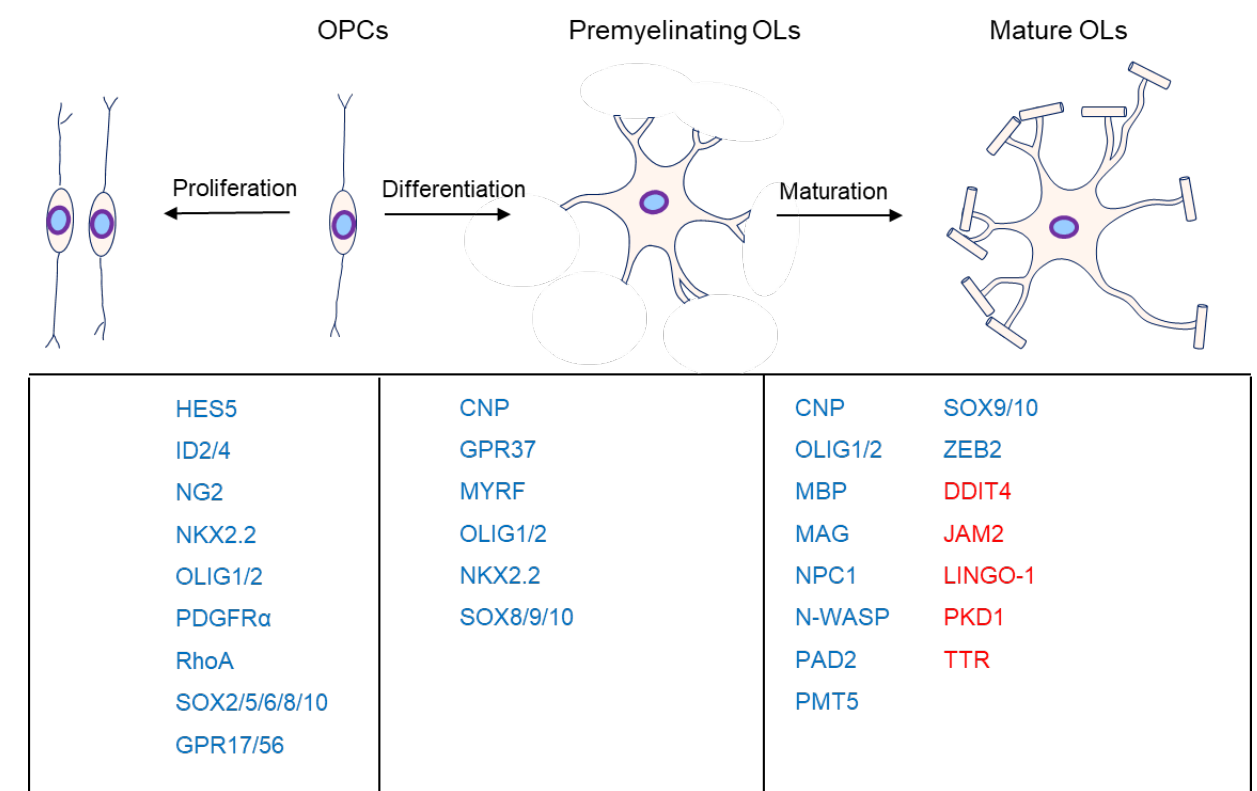
Figure 1. Major markers at the different stages of oligodendrocyte development. OL myelination is mainly divided into proliferation, differentiation, and maturation. The genes associated with the different stages are listed below them. Moreover, genes in blue are the positive markers in OPC proliferation, OL differentiation, or maturation. Specifically, genes in red are inhibitors in OL maturation.